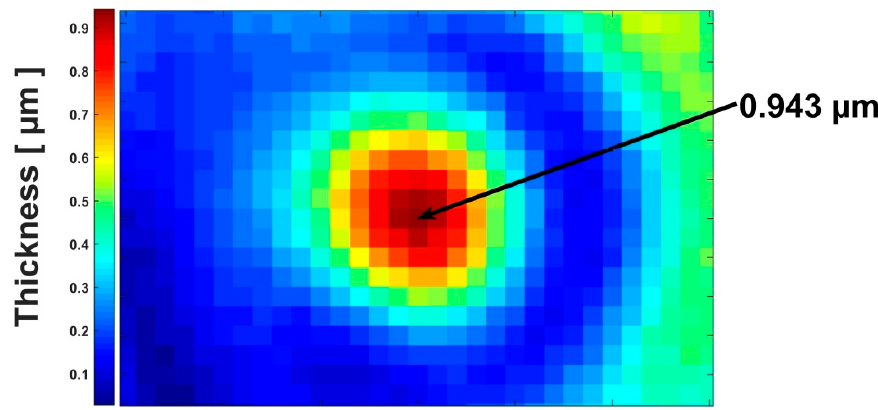
Figure 5. Size’s map for the sample. The intensity of each pixel at a point of the microsphere indicates in µm the thickness (at this point) of the microsphere. The intensity of the pixel in the middle of the microsphere represents its diameter, as indicated by the arrow.